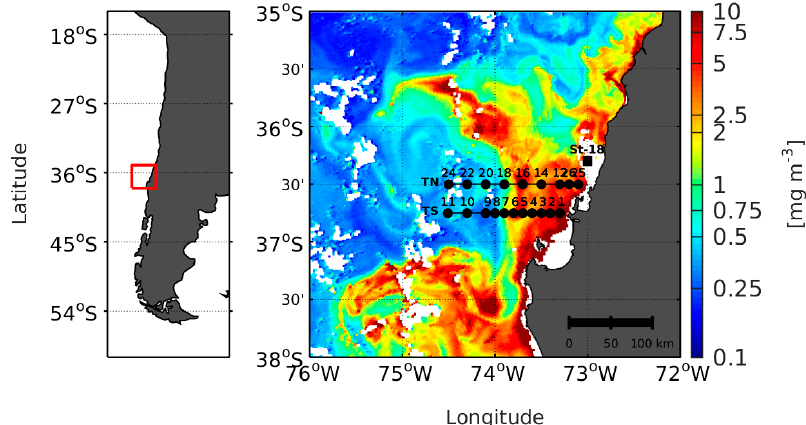
Figure 1. The mean daily chlorophyll-a (Chl-a) concentration derived from MODIS-Aqua for the dates of the PHYTOFRONT cruise (4–6 February 2014). The black lines and dots indicate the two transects and the stations sampled. The square symbol indicates the location of the time-series station St. 18.